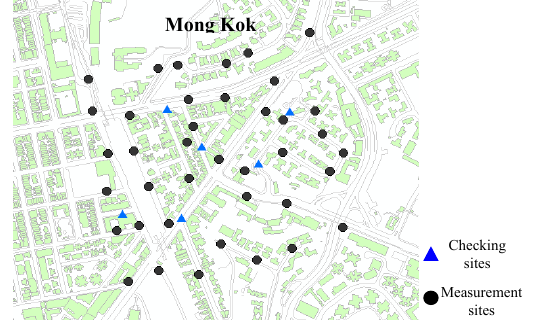
Figure 5. Sites for NSB measurement in Mong Kok